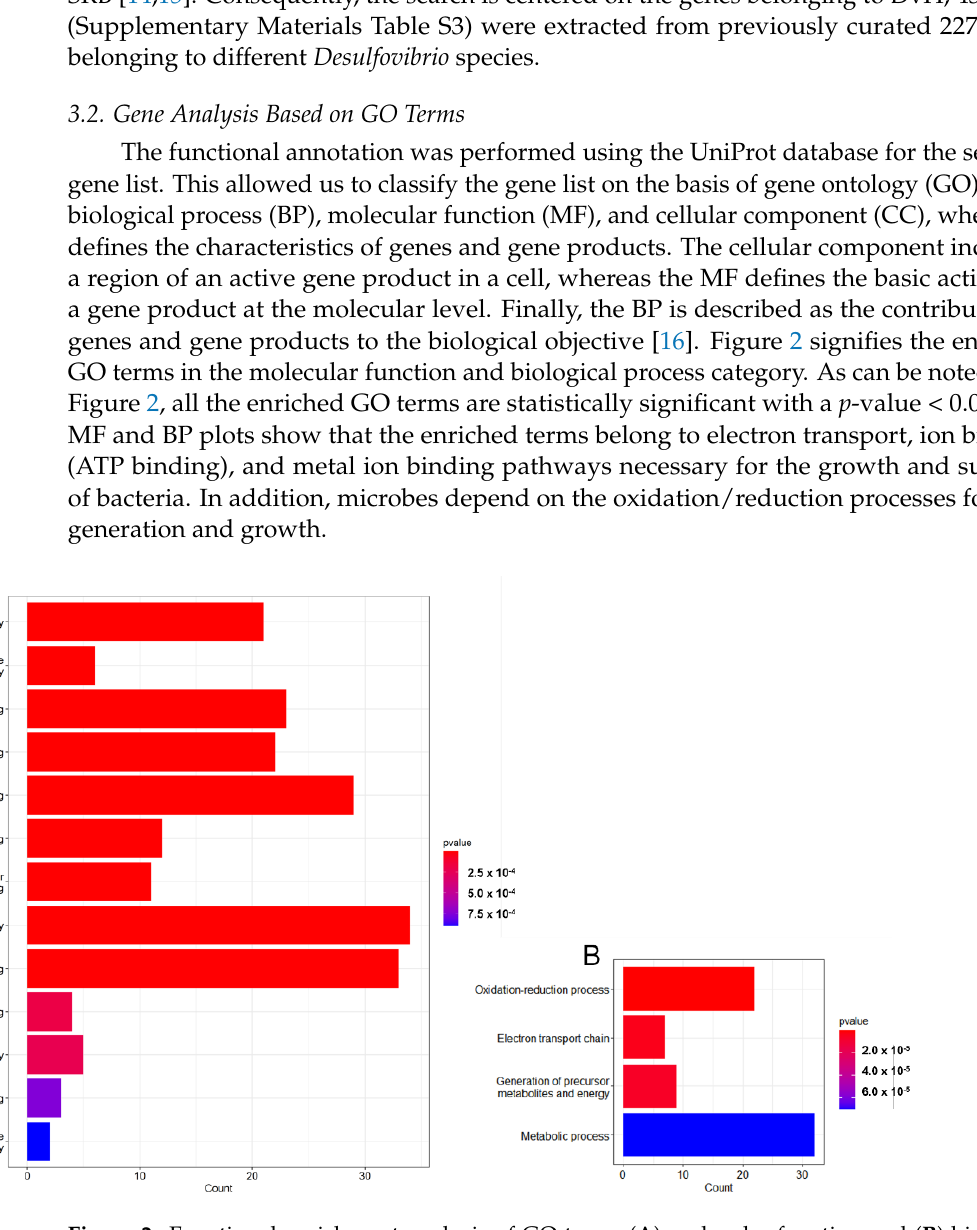
Figure 2. Functional enrichment analysis of GO terms ( A ) molecular function and ( B ) biological process. All the terms are statistically significant with a p -value < 0.05.